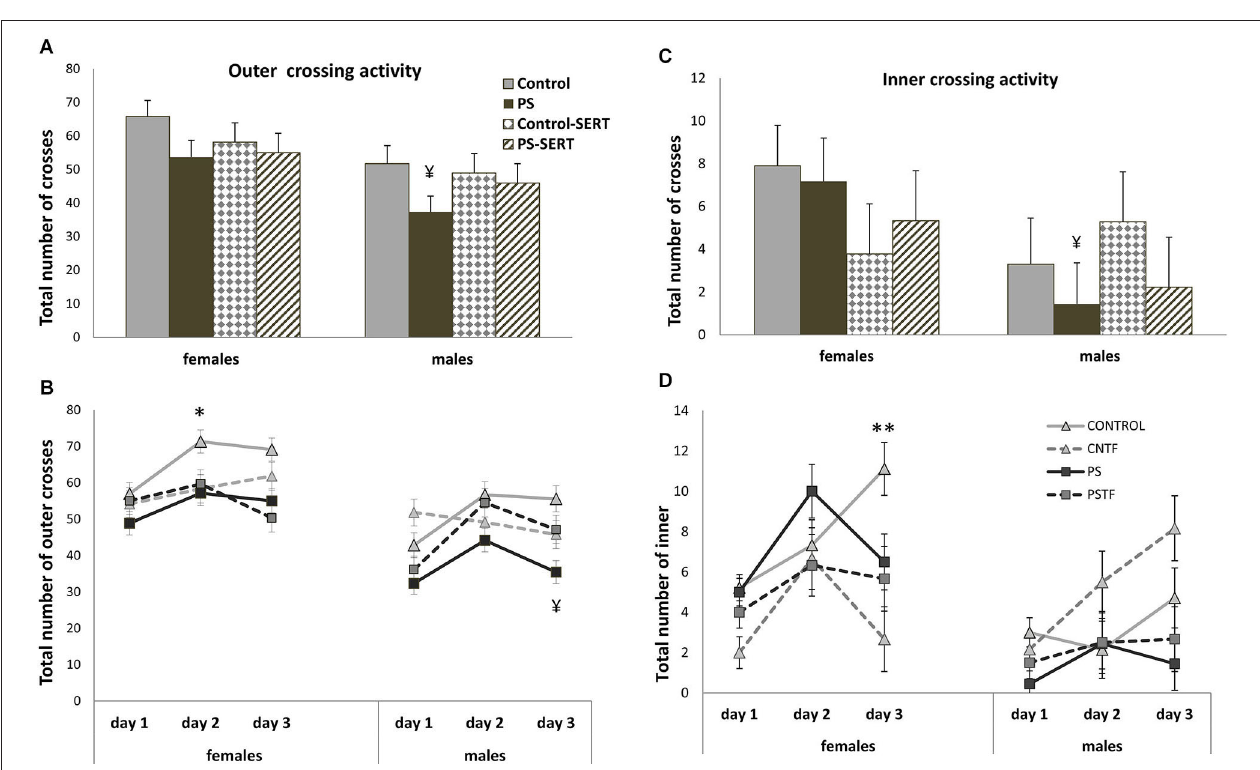
SERT-treatment were found in outer crossing activity, F 3,69 = 2.47; or inner crossing activity, F 3,69 = 0.25. (cid:85) , p < 0.05 indicates a main effect of sex on PS animals. * p < 0.05 and ** p < 0.01, indicates a significant increase on both the number of outer and inner crosses in Control